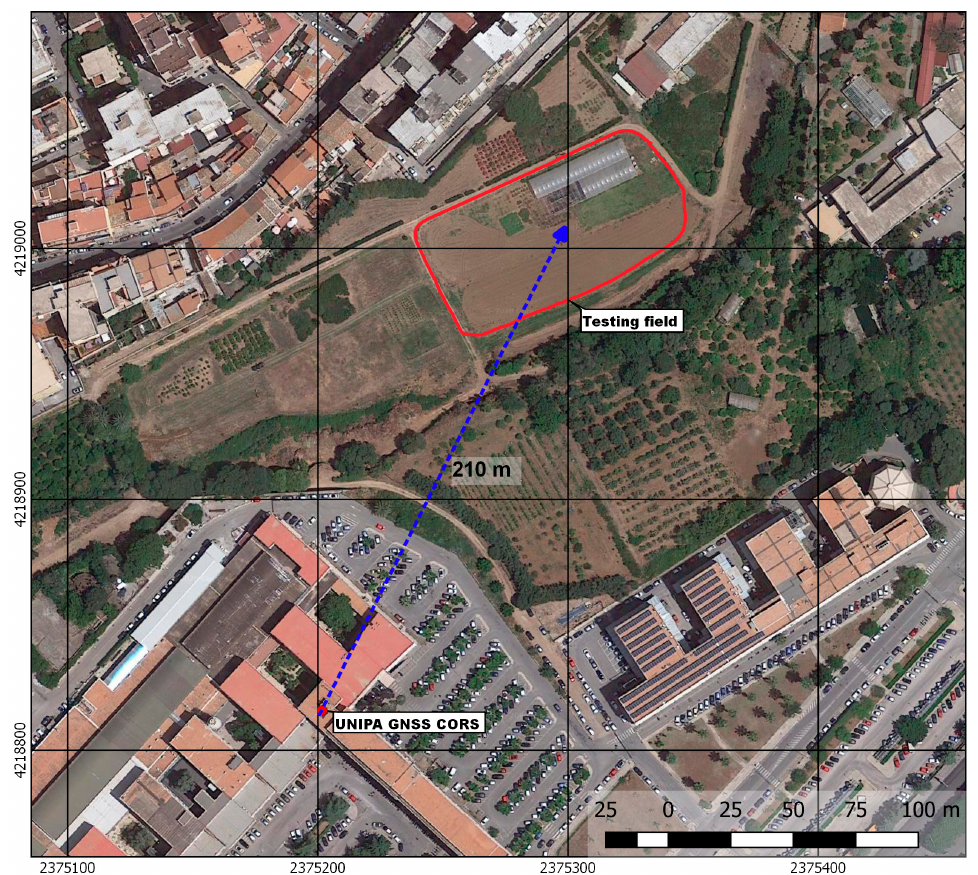
Figure 1. Representation of the testing field and UNIPA Global Navigation Satellite System (GNSS) Continuously Operating Reference Stations (CORS) station (coordinates are given in Gauss-Boaga Coordinate System).